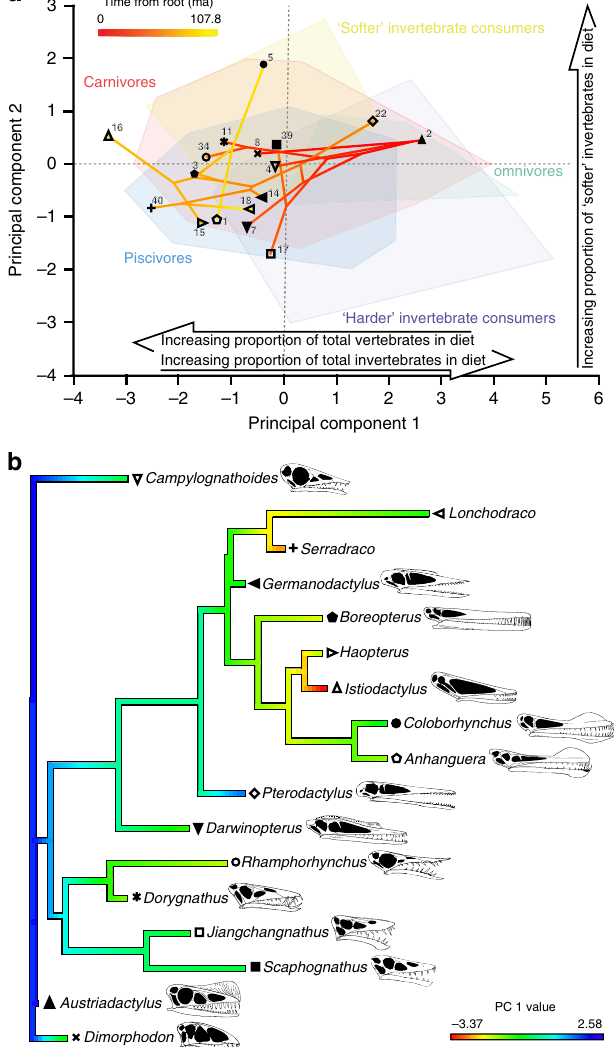
Fig. 4 Pterosaur dietary evolution. a Phylo-texture-dietary space of pterosaur microwear from projecting a time-calibrated, pruned tree from Lü et al. 33 onto the fi rst two PC axes of the extant reptile texture-dietary space. b Ancestral character-state reconstruction of pterosaur dietary evolution from mapping pterosaur PC 1 values onto a time-calibrated, pruned tree from Lü et al. 33 . To account for ontogenetic changes in diet, only the largest specimen of respective pterosaur taxa, identi fi ed by lower jaw length, were included. Pterosaur symbols same as Fig. 2. Skull diagrams of well-preserved pterosaurs not to scale (see ‘ Methods' for sources). Phylo-texture-dietary space adapted from Fig. 2 of ref. 18